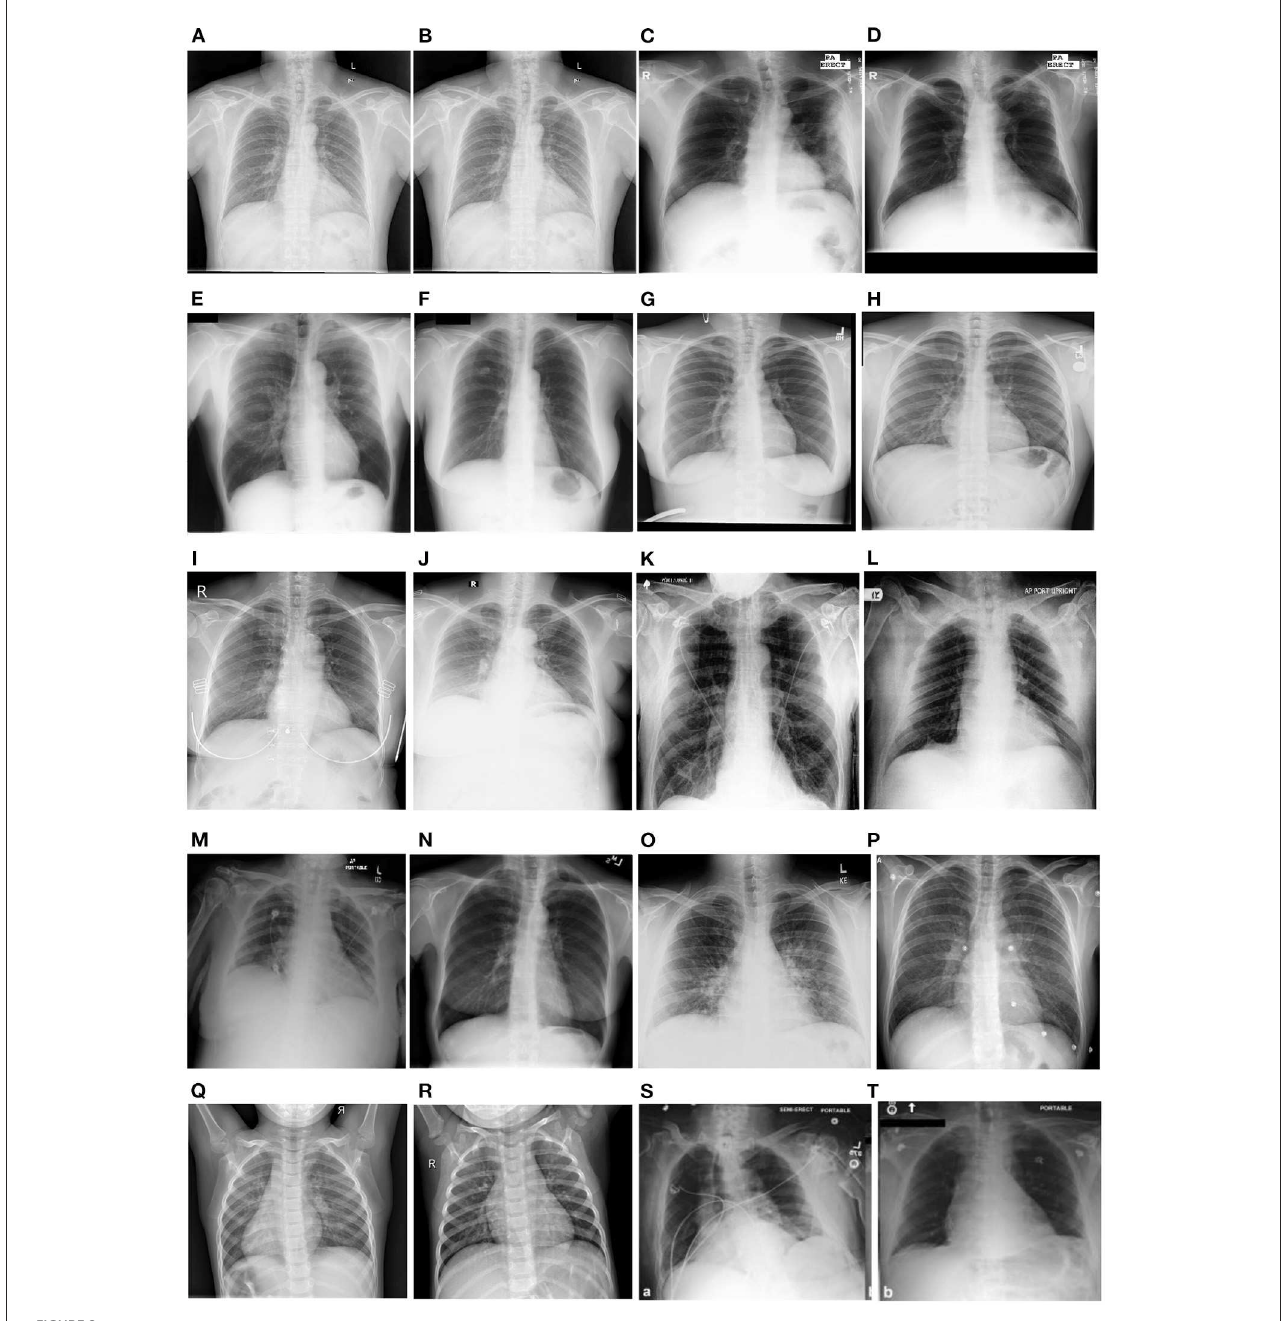
FIGURE8 Showcases the sample examples of the CXRs from different datasets. The samples belong to Shenzhen (A, B) , Montgomery (C, D) , JSRT (E, F) , Chestxray14 (G, H) , VinDr-CXR (I, J) , CheXpert (K, L) , RSNA Pneumonia (M, N) , Covid-CXR (O, P) , PedPneumonia (Q, R) , and MIMIC-CXR (S, T) . The samples across different datasets highlight a wide variety in terms of quality, contrast, brightness and original image